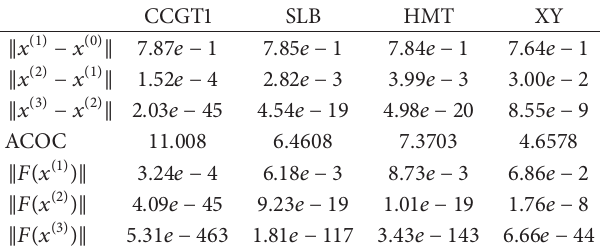
Table 8: Numerical results for Example 3 and initial guess 𝑥 (0) = (1,1,1,0)